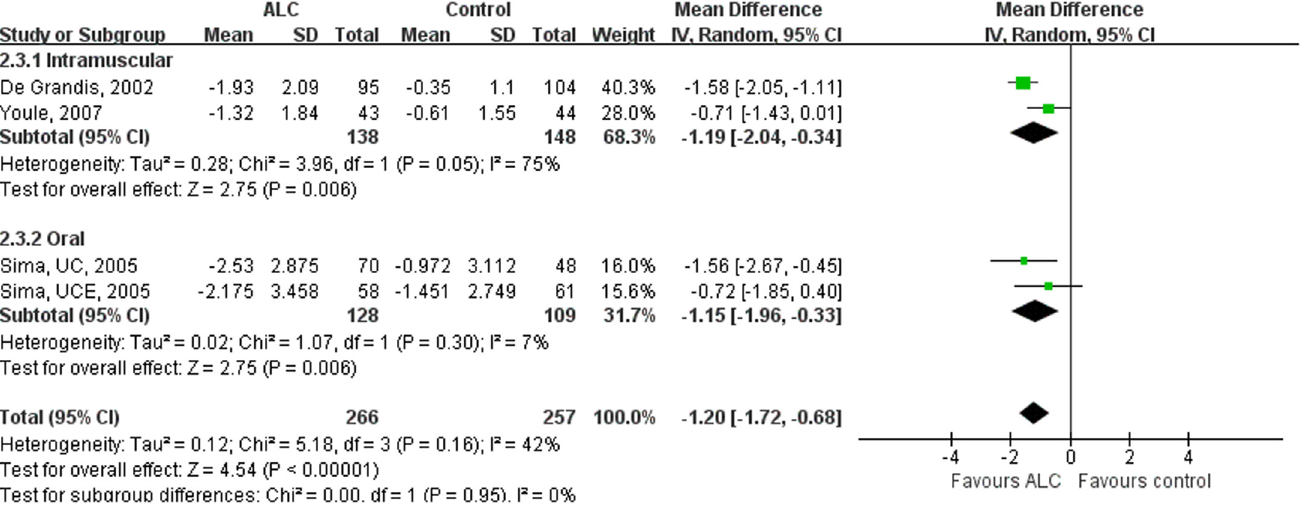
Fig 4. Subgroup-analysis on the VAS Scores by Subdividing RCTs according to the Route of Administration. Oral administration of ALC decreased VAS scores significantly. VAS = Visual Analogue Scale; ALC = acetyl-l-carnitine; UCE = U.S.-Canadian-European Study; UC = U.S.-Canadian Study; SD = standard deviation; CI = confidence